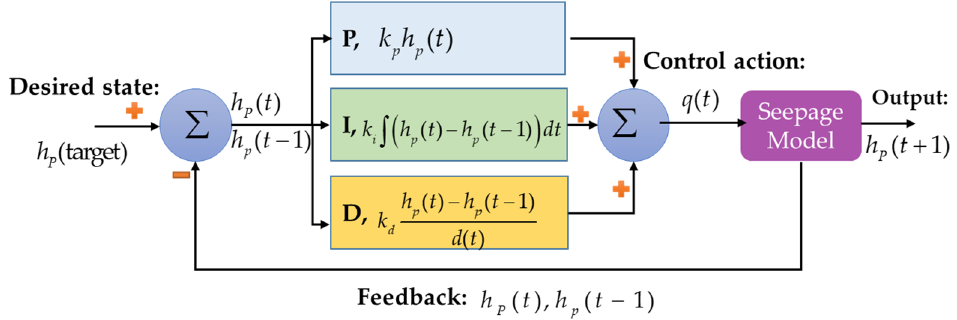
Figure 5. PID loop control for the geosystem.